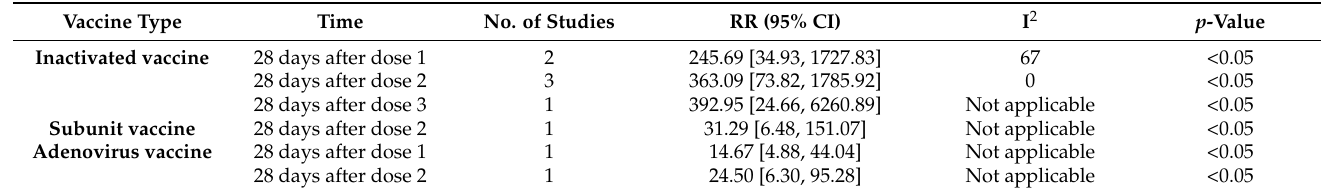
Table 9. Neutralizing antibody in the vaccine groups versus the control groups.